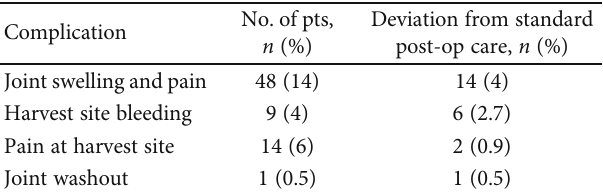
Table 9: Complications associated with intra-articular injection of the knee with